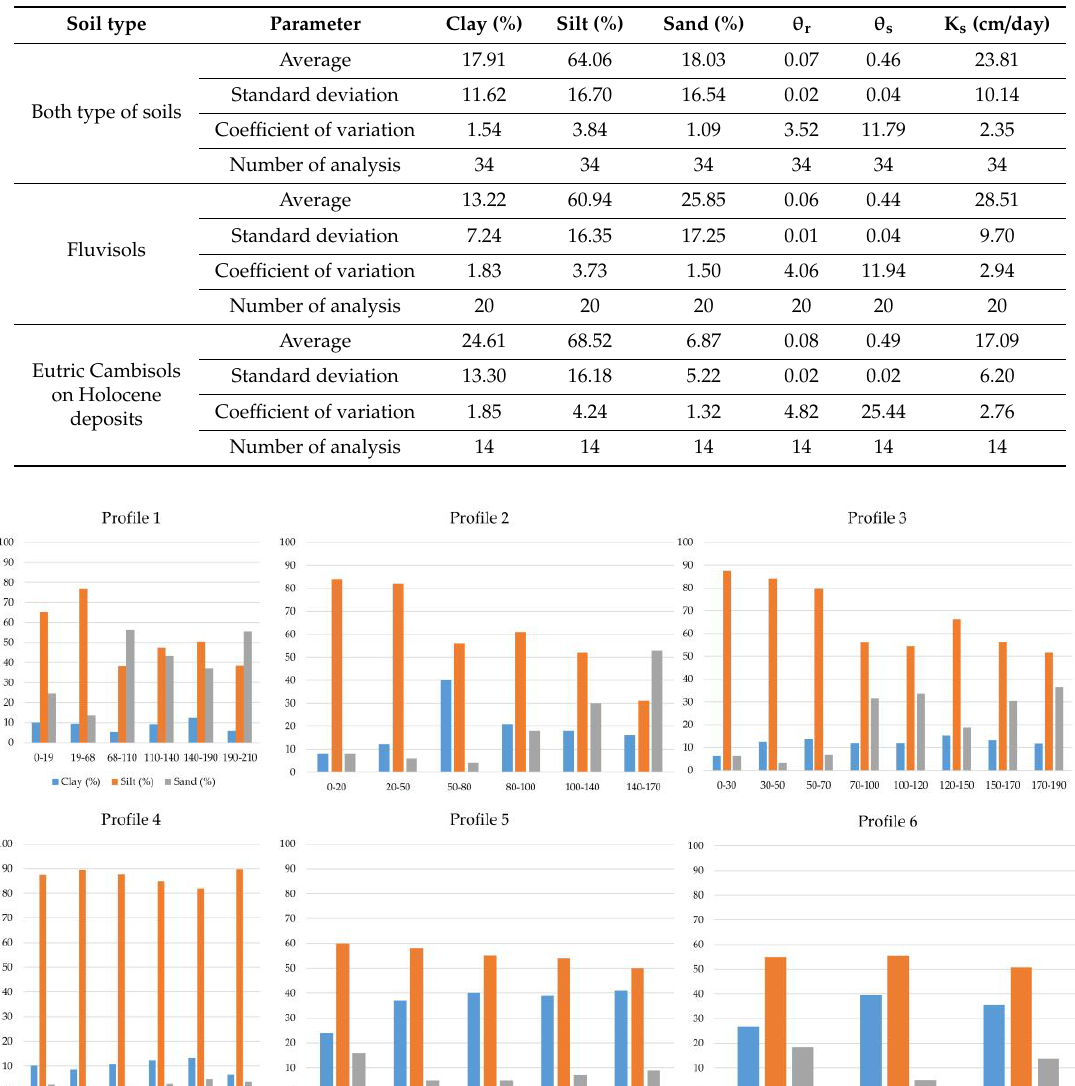
Table 4. Average values for the particle size distribution and soil hydraulic parameters.